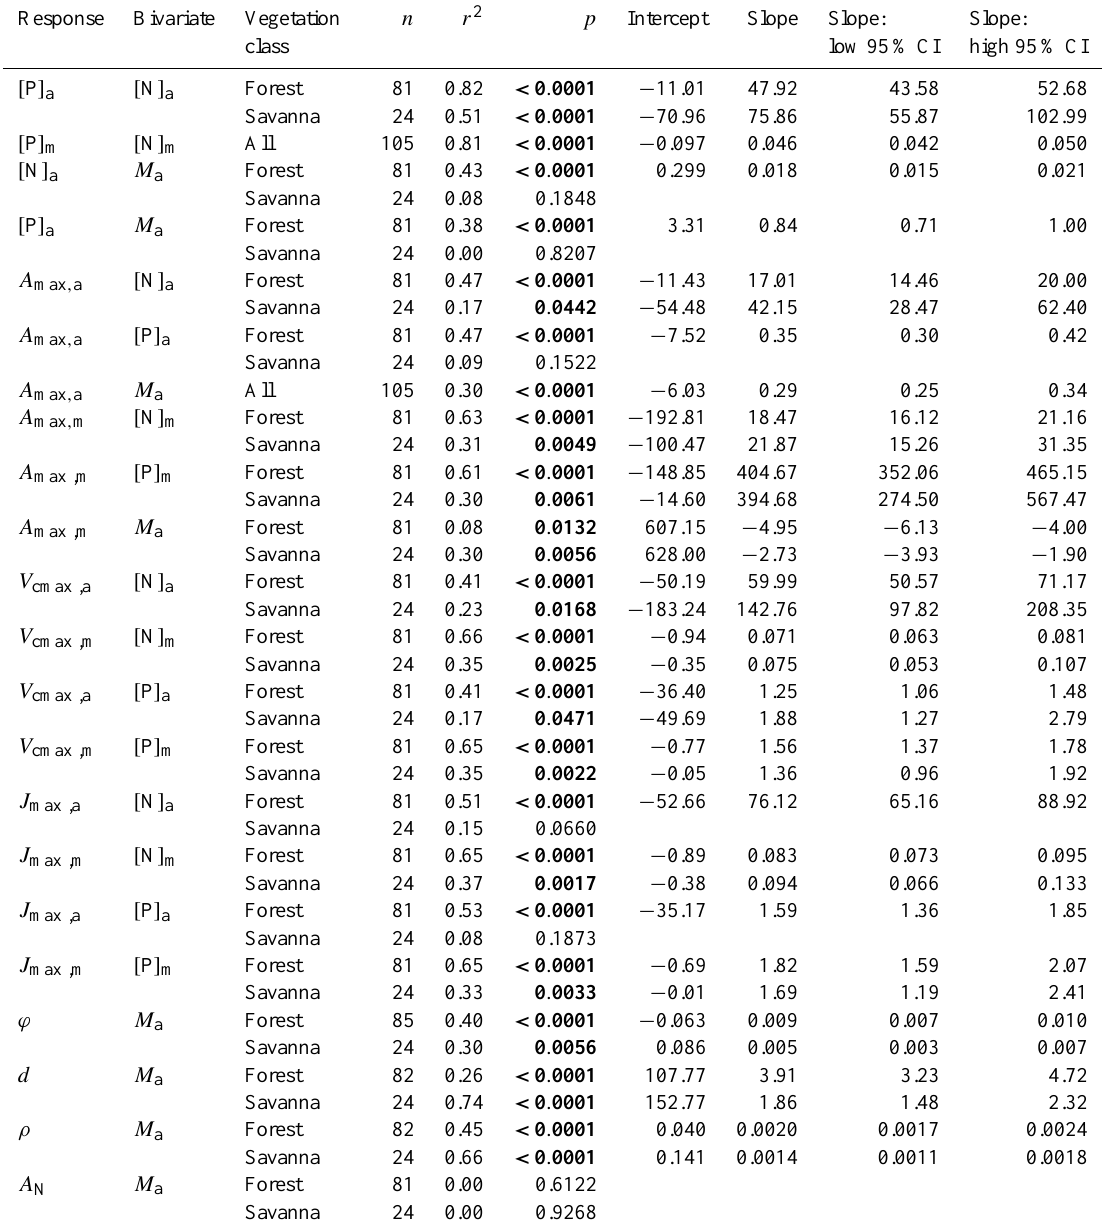
Table 3. Coefficients for SMA bivariate relationships. Vegetation contrasts: forest and savanna; n , number of observations; r 2 , correlation coefficient and associated p value; intercept; slope and 95% confidence interval